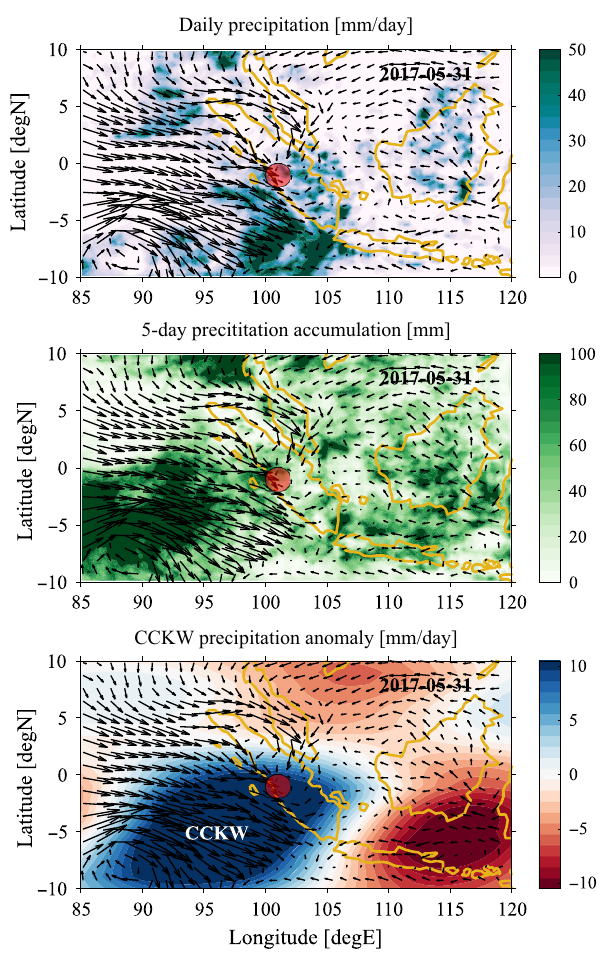
Fig. 3 Meteorological conditions during Padang fl ood on 31 May 2017. Map of meteorological conditions on 31 May 2017. a the daily precipitation rate [mm/day], ( b ) 5-day precipitation accumulation [mm] and ( c ) convectively coupled Kelvin wave precipitation anomaly [mm/day]. Superimposed are 850 mb anomalous wind vectors. Marker indicates the Padang fl ood